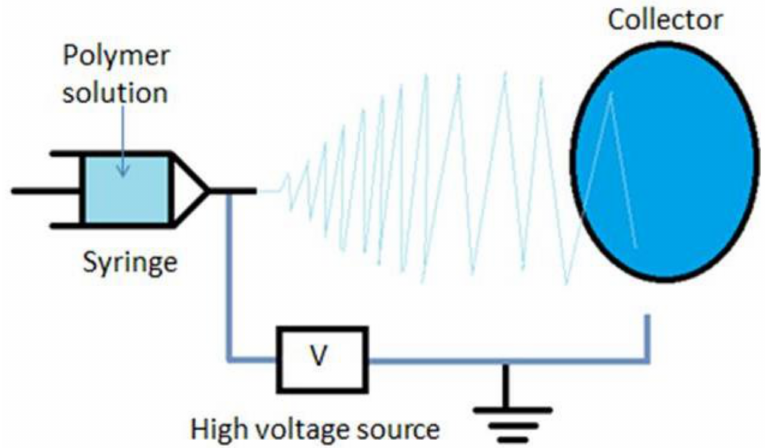
Figure 1. A schematic diagram of the electrospinning